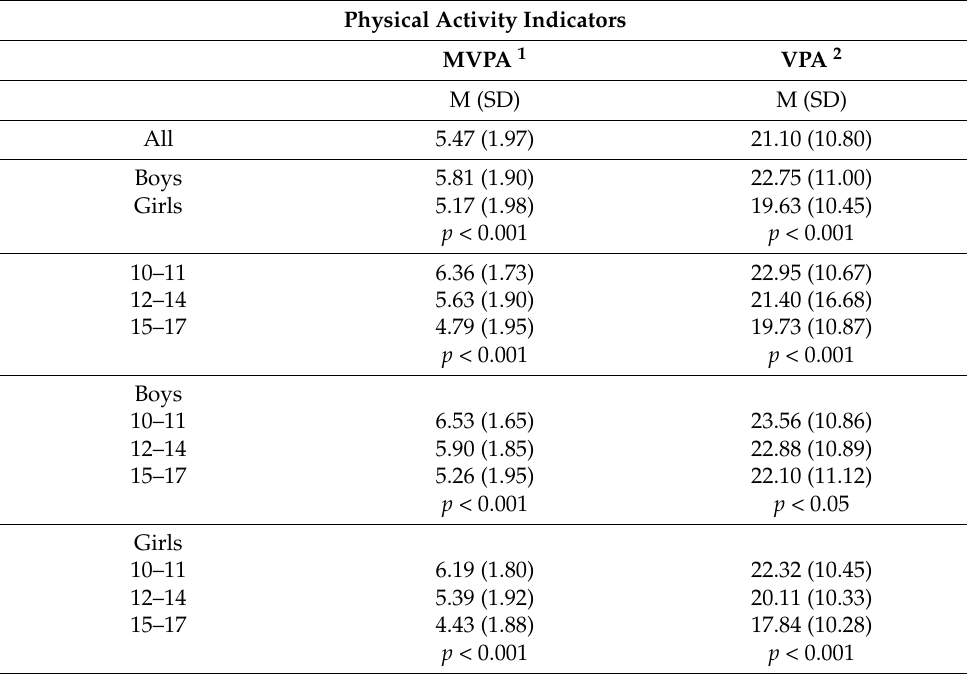
Table 2. Indicators of physical activity by intensity, gender and age